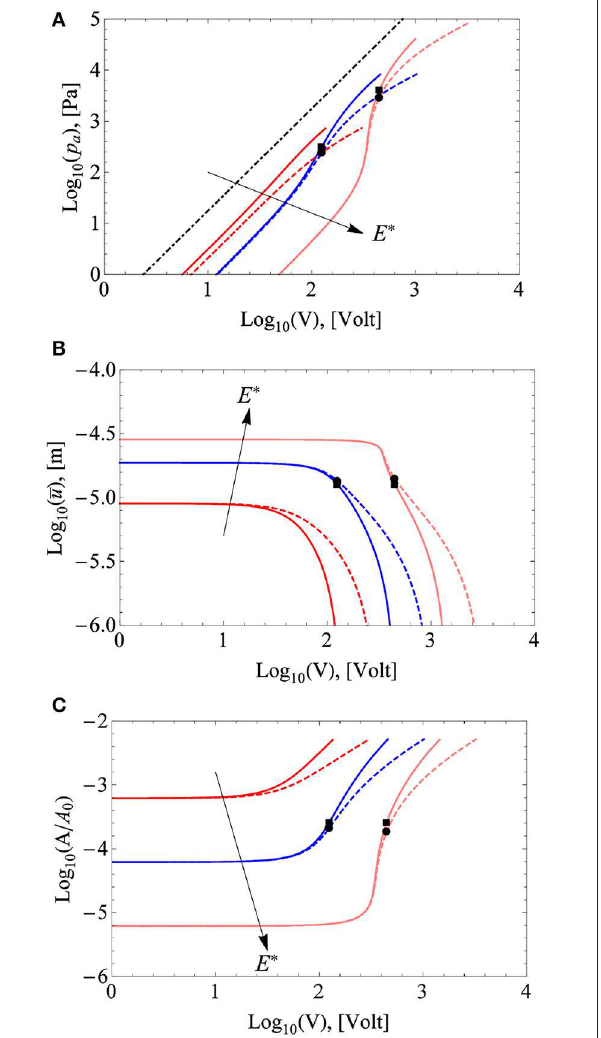
FIGURE 9 | (A) Adhesive pressure p ad (C) normalized contact area A / A 0 as functions of the applied voltage V for E * [1,10,100] MPa and for both insulating (solid lines) and conducting (with = d 0 10mm, dashed lines) solids. All plots are for a constant external pressure = p ext 100 Pa. In (A) , the dot-dashed line represents the theoretical = electroadhesive strength σ 0 . In all panels the black circles and squares represent estimates of the critical voltage υ full using Equations (23) and